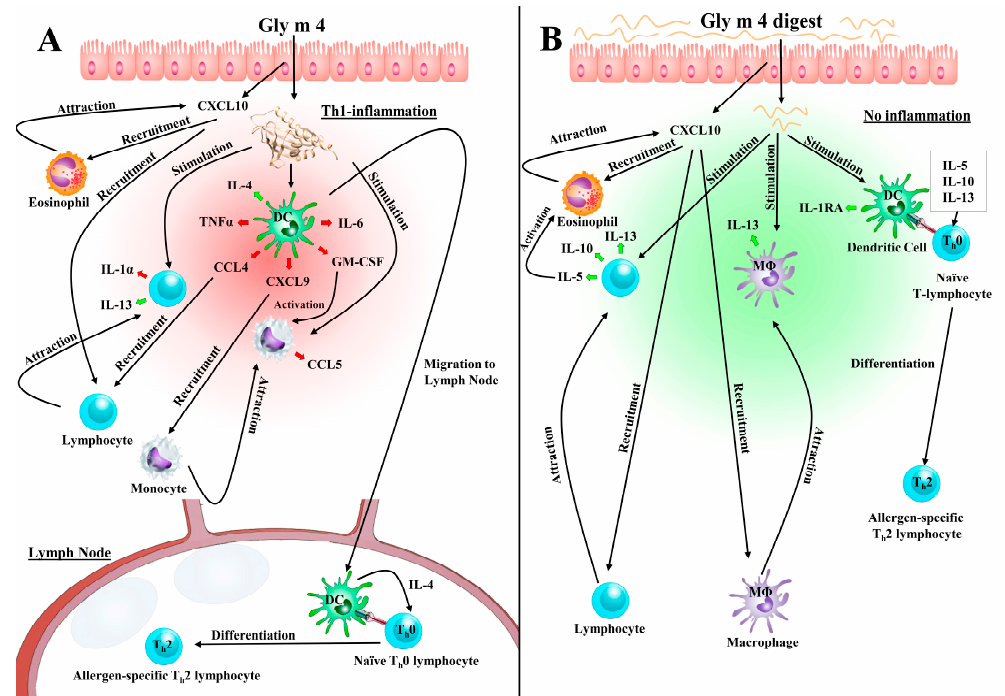
Figure 9. Two possible ways of sensitization with the soybean allergen Gly m 4 based on experimental data obtained in the current study. ( A ) If Gly m 4 can reach the human intestine in intact form, it is able to cross the intestinal epithelium and induce the production of several pro-inflammatory stimuli by different cells, as well as high levels of IL-4 by DCs. Gly m 4-stimulated DCs migrate to the lymph node from intestinal Th1-inflammatory site and induce there IL-4-dependent differentiation of naïve Th0 lymphocytes into allergen-specific Th2 lymphocytes. ( B ) The second proposed mechanism of sensitization is mediated by proteolytic fragments of Gly m 4 that resulted after gastrointestinal digestion. Some of the proteolytic fragments are able to cross the intestinal epithelium and induce the production of several anti-inflammatory stimuli, namely, (IL-1RA), IL-5, IL-10, and IL-13, which leads to the differentiation of naïve Th0 lymphocytes into allergen-specific Th2 lymphocytes in the intestinal lamina